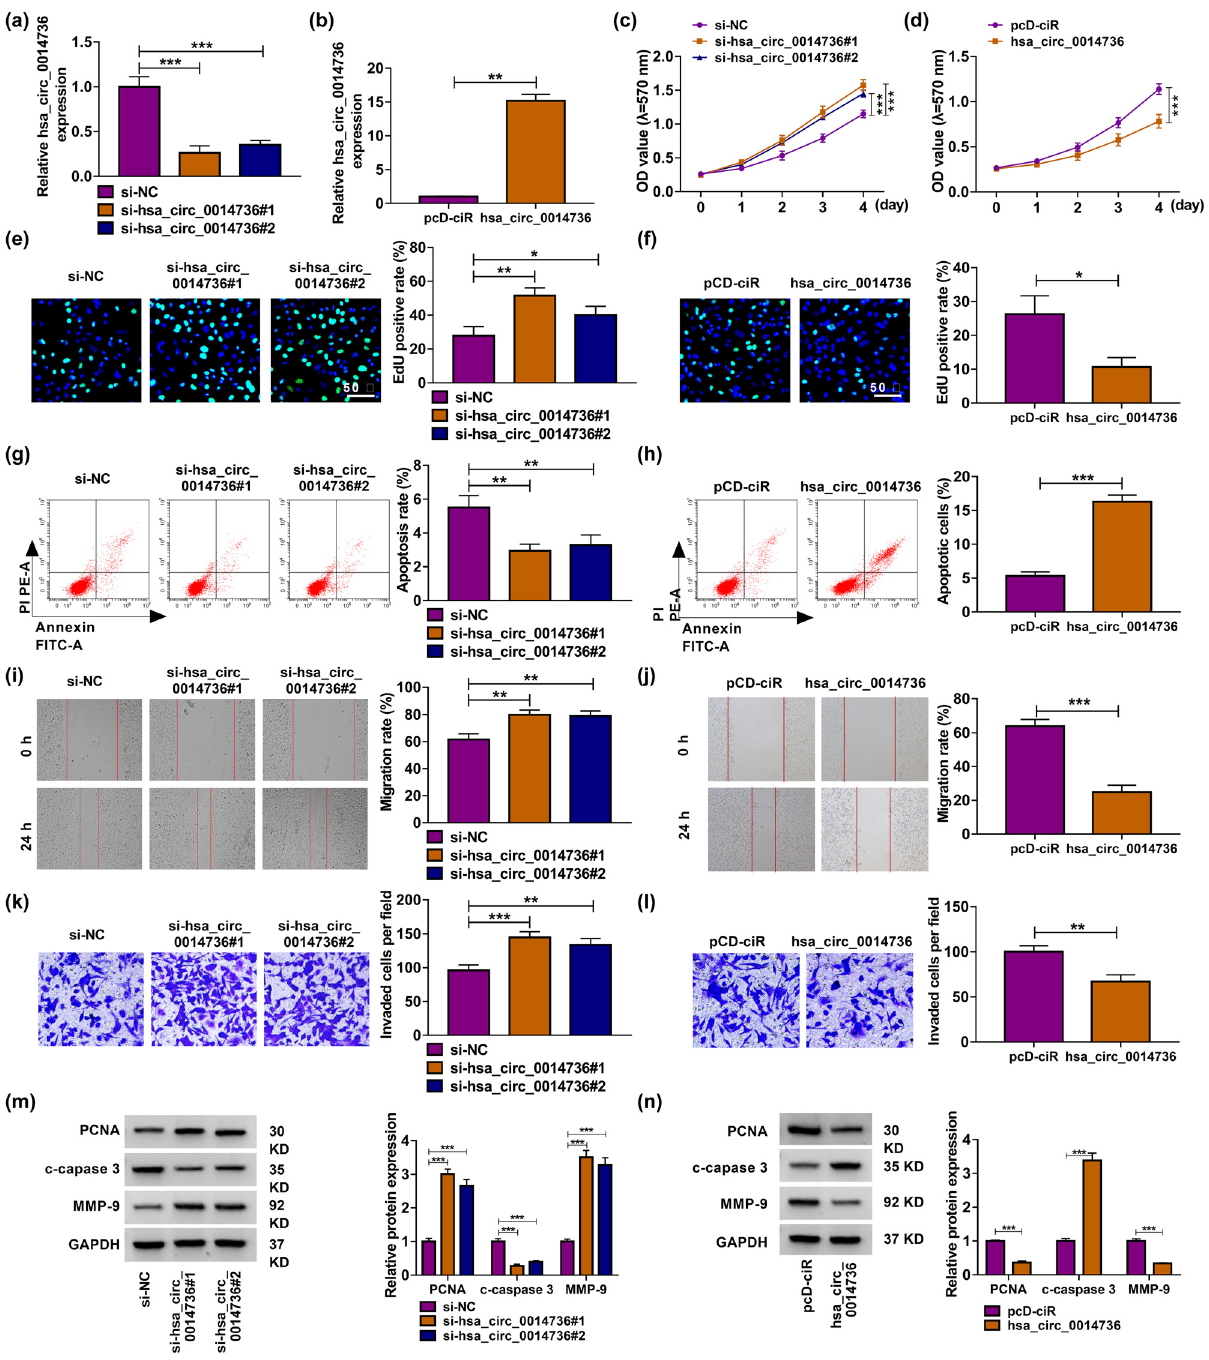
Figure 2: E ff ects of circ_0014736 on the proliferation, migration, invasion, and apoptosis of HTR - 8/SVneo cells. ( a and b ) E ffi ciency of circ_0014736 knockdown and overexpression was determined by qRT - PCR in HTR - 8/SVneo cells. HTR - 8/SVneo cells were transfected with si - NC, si - hsa_circ_0014736#1, and si - hsa_circ_0014736#2 ( c, e, g, i, k, and m ) , or pcD - ciR and hsa_circ_0014736 ( d, f, h, j, l, and n ) . ( c – f ) Cell proliferation was investigated by MTT and EdU assays. ( g and h ) Cell apoptosis was quanti fi ed by fl ow cytometry analysis. ( i – l ) Migration and invasion were evaluated by wound - healing and transwell assays, respectively. ( m and n ) Expression of PCNA, c - caspase 3, and MMP - 9 was checked by western blot. * P < 0.05, ** P < 0.01, and *** P < 0.001. Three independent duplicate tests were performed in each